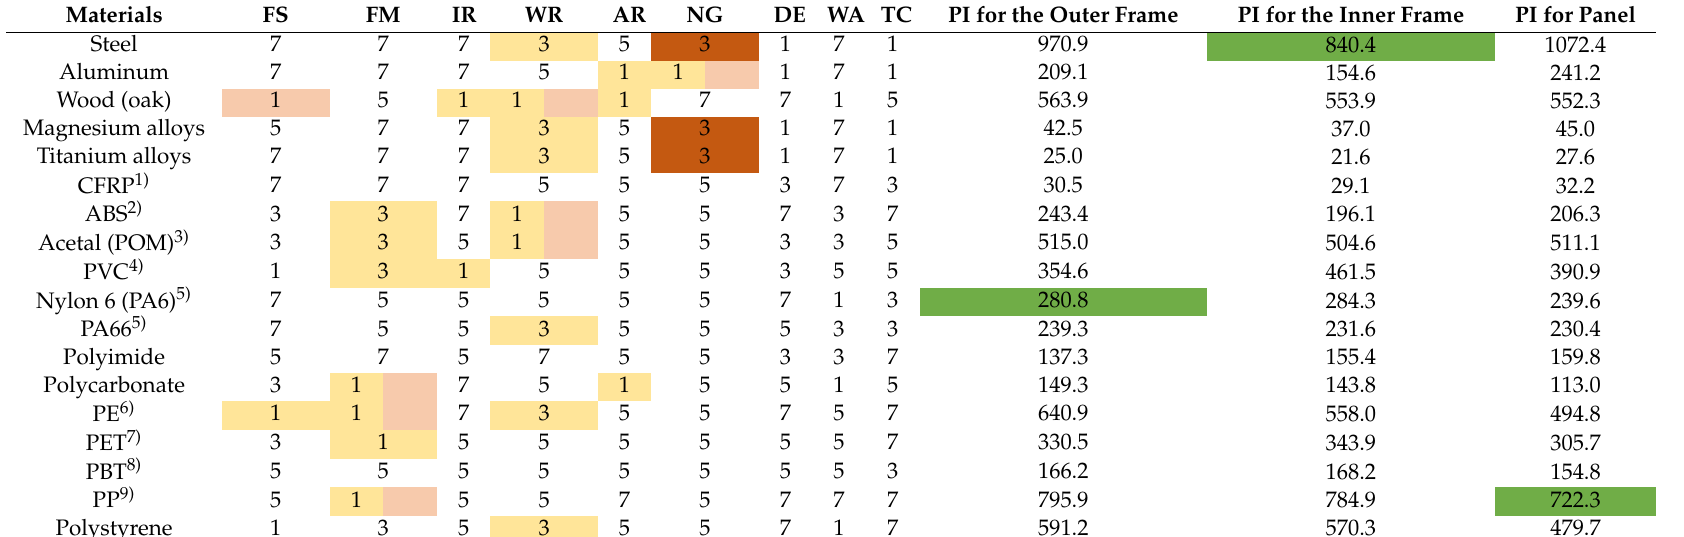
Table 7. Scoring for priority index (PI) using material properties and relative weights of